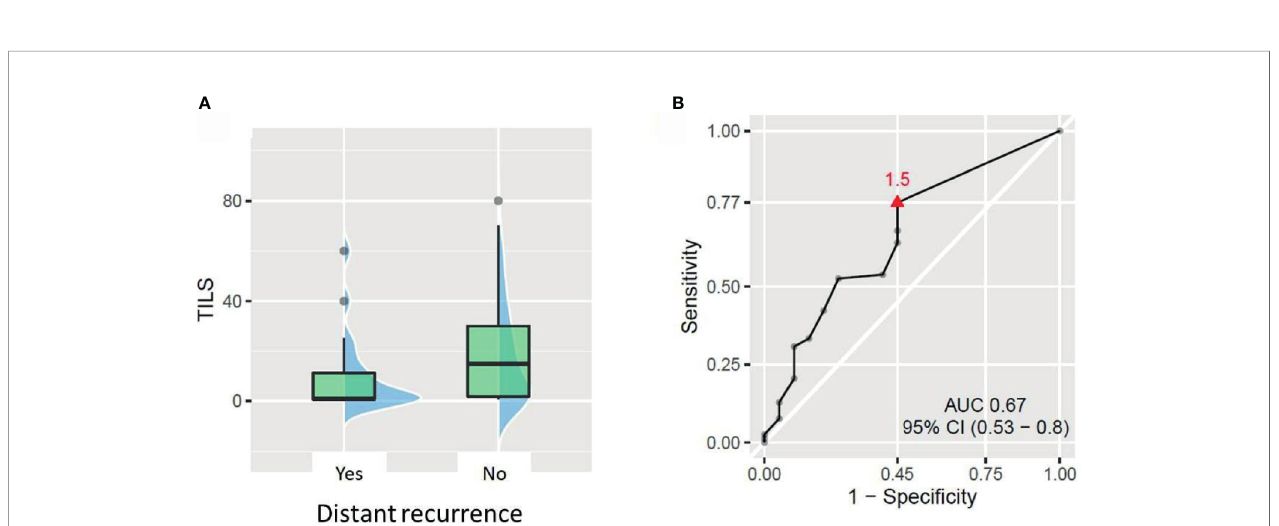
FIGURE 3 | Relationship between tumor-in fi ltrating lymphocytes (TILs) and distant recurrence. (A) Patients with distant recurrences had lower baseline TILs (p = 0.021). (B) ROC curve showing the best TIL cut-off for predicting the patient risk of distant recurrence.